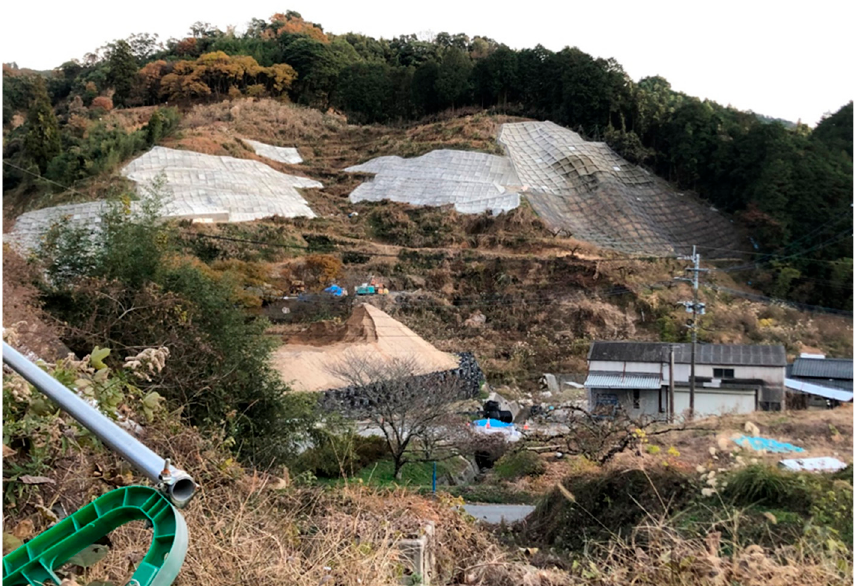
Figure 2. Ongoing road restorations and slope protection constructions in the Hiraenoki Community (obtained by Yoshio Harada [the first author] on 12 December 2019).